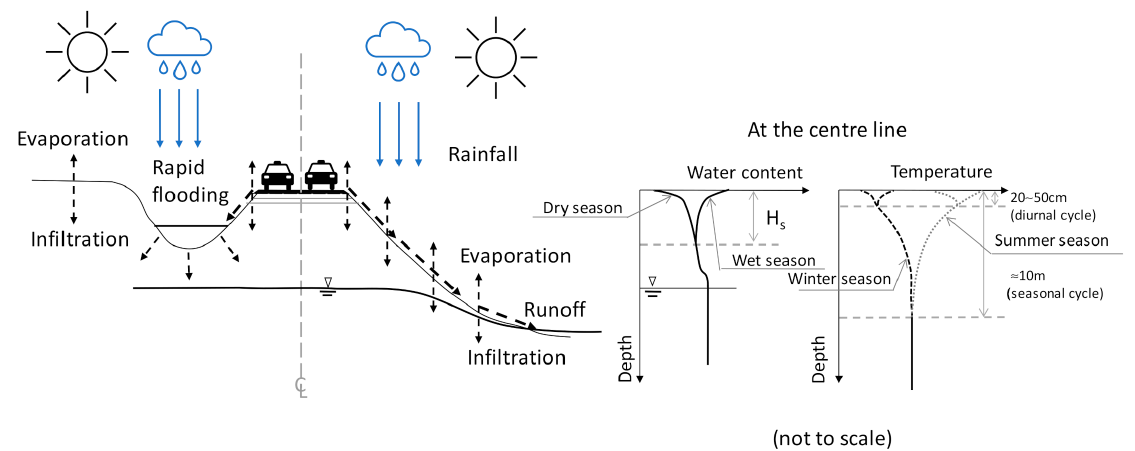
Figure 9. Diagram of a roadway embankment subjected to seasonal climatic